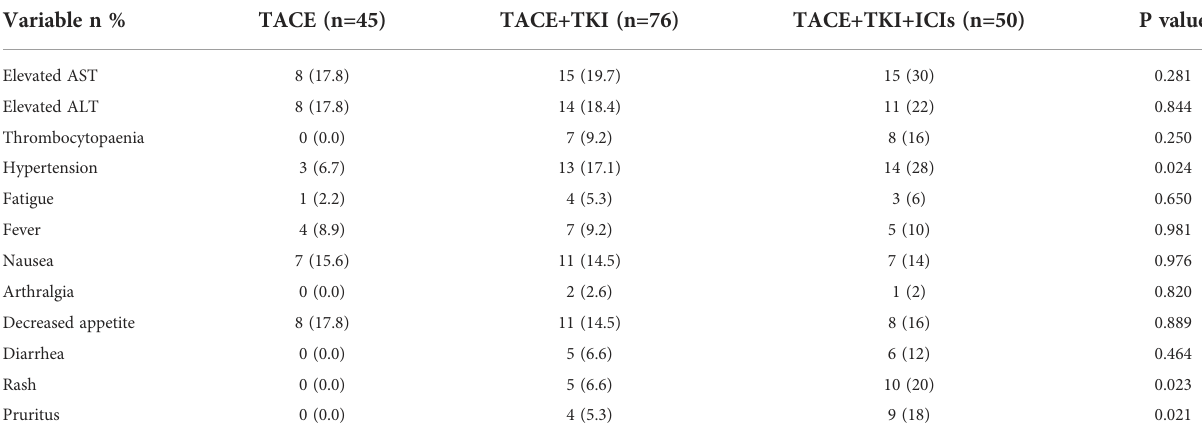
TABLE 3 Key treatment-related adverse events of = grade